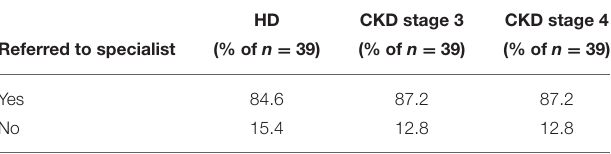
TABLE 10B | HCV + patients are usually referred to a liver/gastroenterology specialist, by ESKD stage (China Medical Director HCV survey,